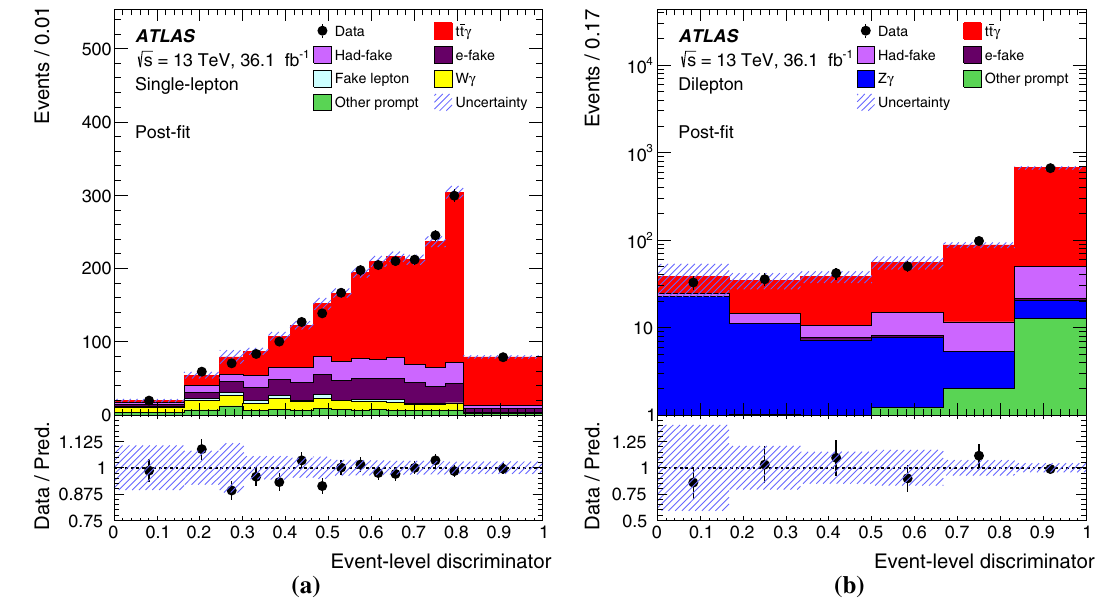
Fig. 7 The post-fit ELD distributions for the a single-lepton and b dilepton channels. All the systematic uncertainties are included